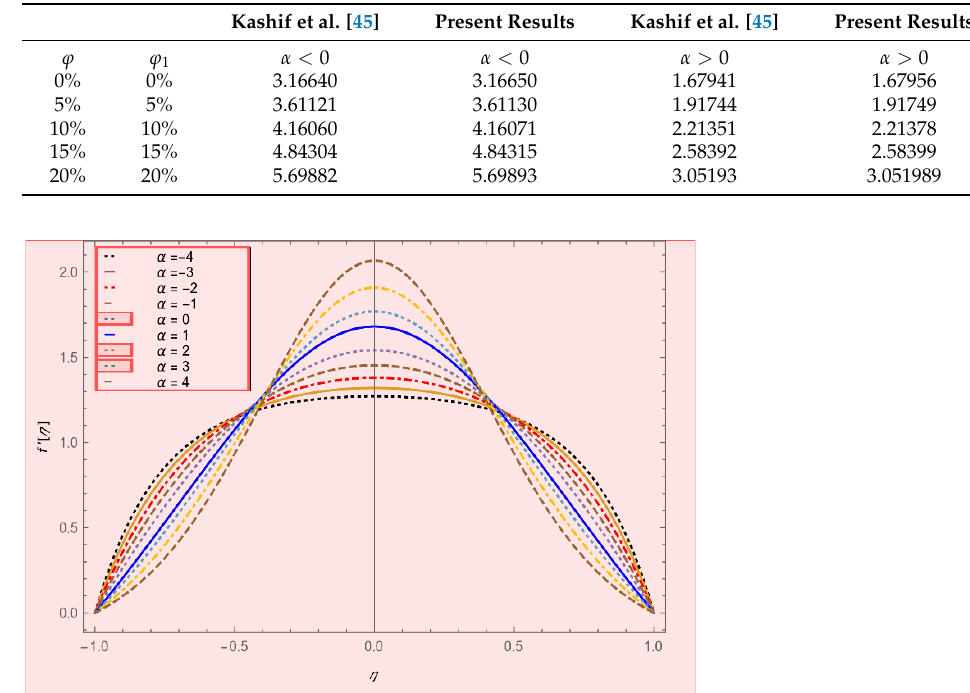
Figure 2. Radial velocity profiles for 𝜑 1 = 𝜑 2 = 0.01, 𝑆𝑐 = 1,𝑀 = 1, 𝑅𝑒 = −1,𝑃𝑟 = 6.2.